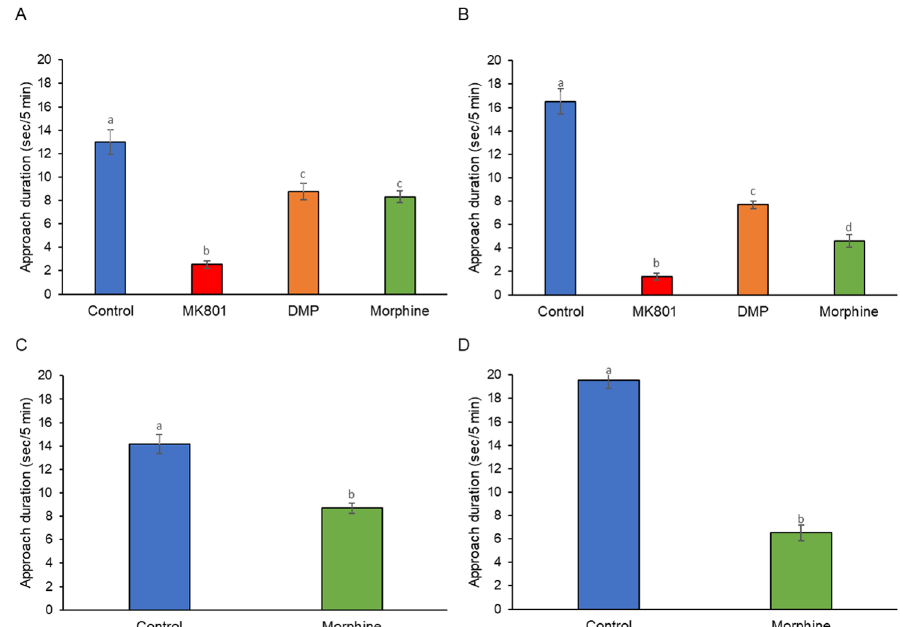
Figure 3. Effects of ( A ) short-term (F (3, 140) =42.92, p = 0.00) and ( B ) long-term (F (3, 140) = 114.29, p = 0.00) exposure to MK801, DMP, and morphine, and after withdrawal of ( C ) short-term (t (70) = 35.31, p = 0.03) and ( D ) long-term (t (70) = 177.64, p = 0.00) morphine treatment on the social preferences of zebrafish larvae (sec/5 min). Data expressed as mean ± SEM, n = 12 of 3 independent experiments. Different alphabets indicate statistically significant values, p < 0.05. Drug abbreviation: DMP,